Question: Judging by this figure, is the value going up or going down?
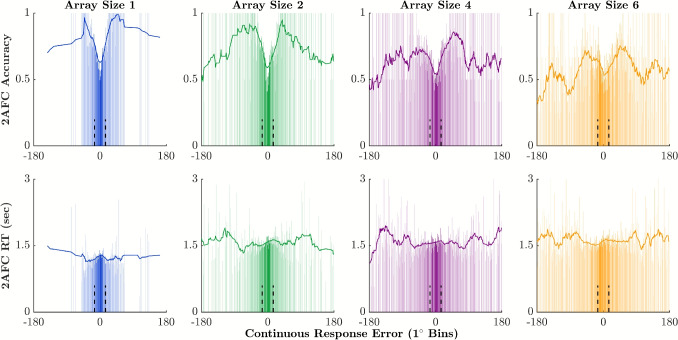
Answer: increasing